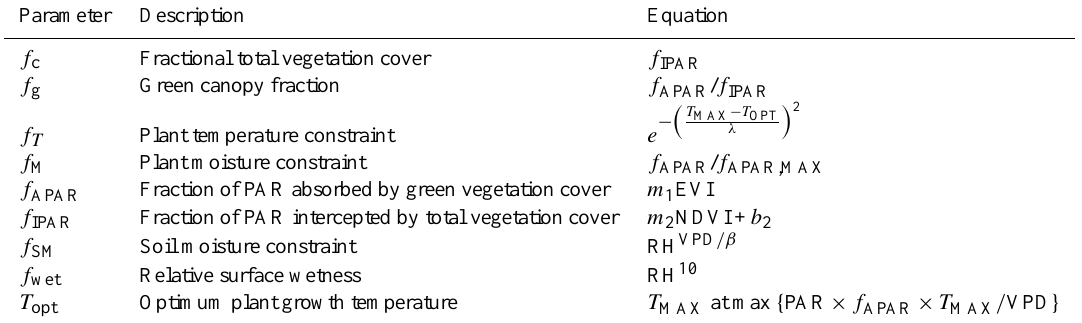
Table 2. Model parameters and equations for the PT-JPL Model, where λ = T OPT , m 1 = 1 . 2, m 2 = 1 . 0, b 2 = − 0 . 05, and β = 1 . 0. Parameter Description Equation f c Fractional total vegetation